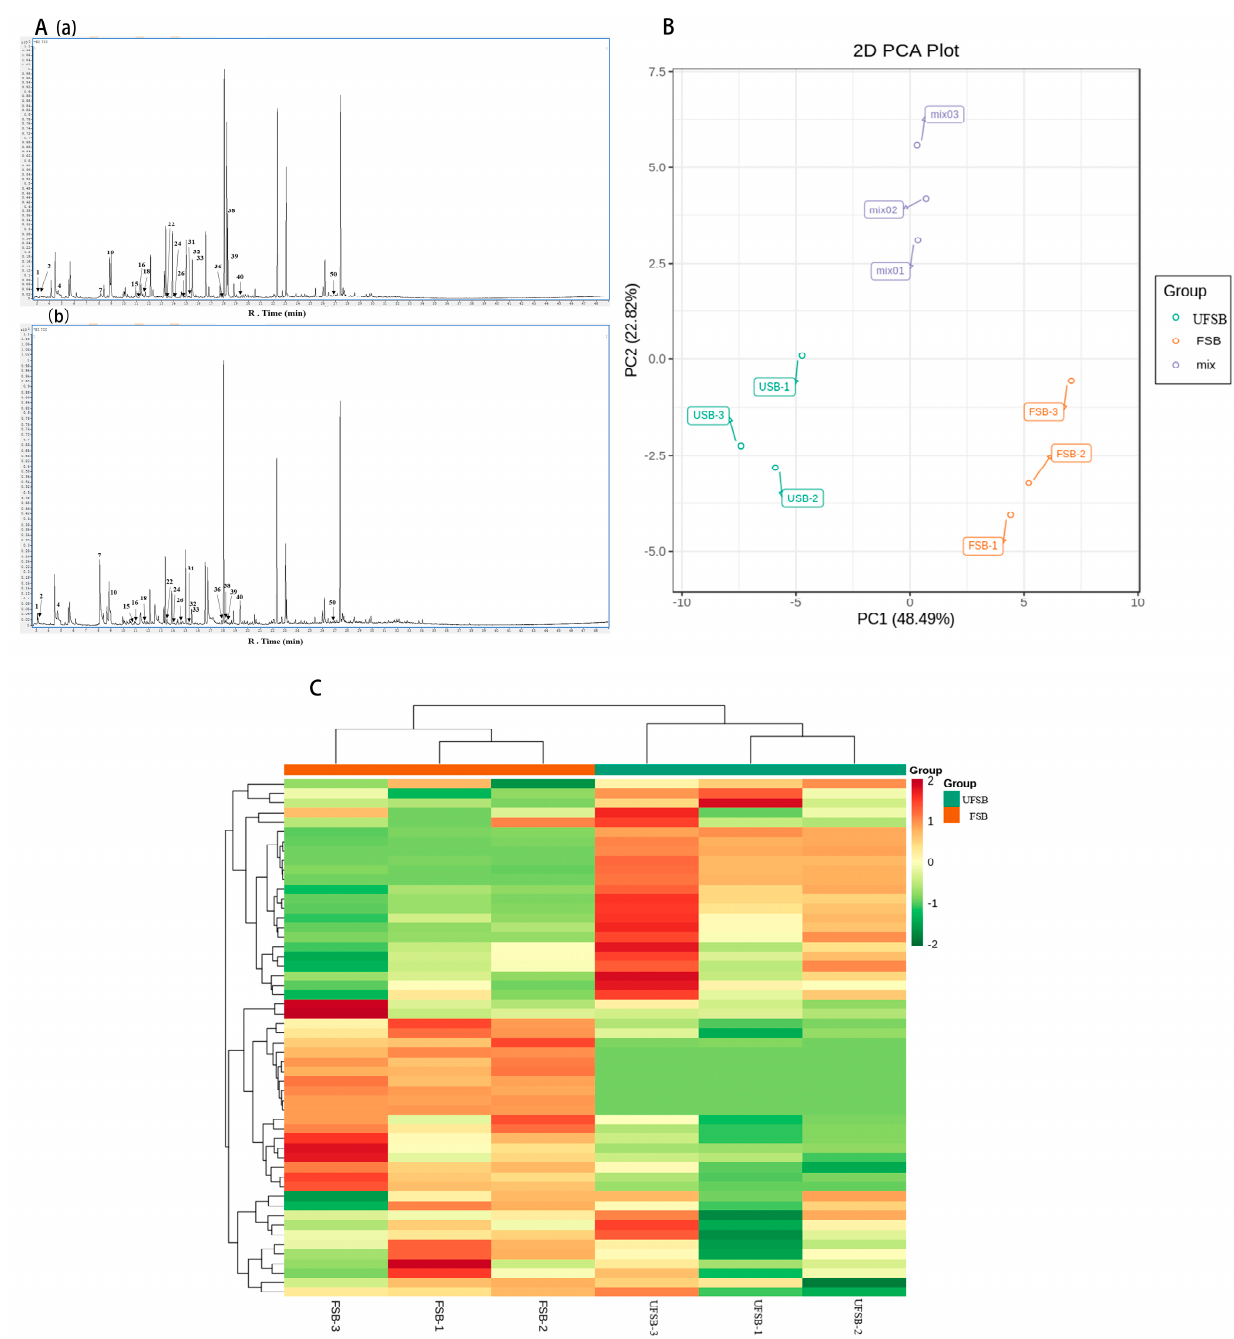
Figure 3. The volatile organic compounds analysis in soy beverage by HS-SPME-GC-MS. ( A ) GC-MS total ion current chromatograms of ( a ) the unfermented soy beverage and ( b ) the fermented soy beverage with N. aurantialba , ( B ) PCA score of samples, ( C ) heat map visualization of samples.